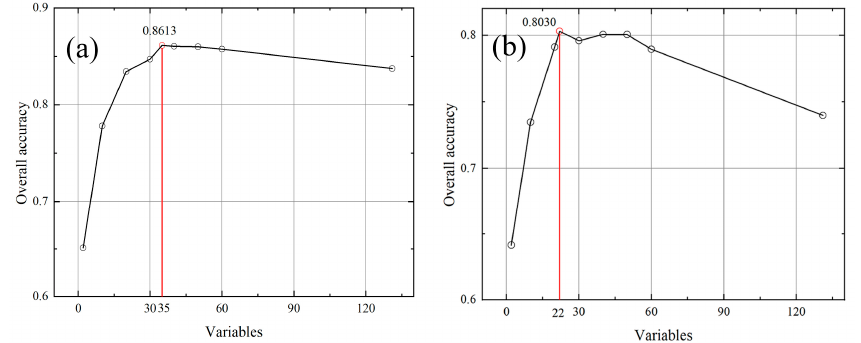
Figure 5. Change of overall accuracy with increasing number of input variables in recursive feature elimination (RFE)-based variable selection (vertical red line corresponds to number of variables and overall accuracy after variable selection). ( a ) GF-1 data, ( b ) ZY-3 data.